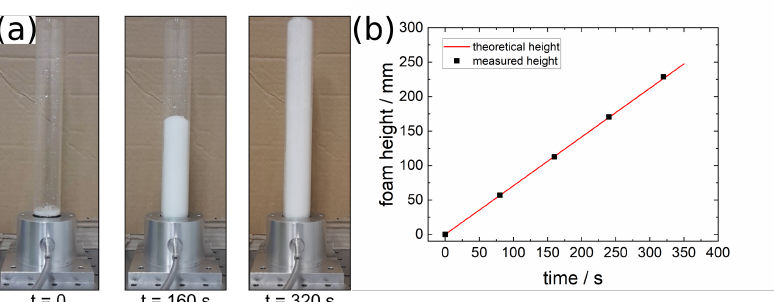
Figure 3. Test of the foaming procedure and tightness of the gas flow system. ( a ) Three pictures of a foaming C 14 TAB ( c = 3.5mM) solution at different times. ( b ) Foam height as a function of time (black squares) and the theoretical height (red line) according to Equation